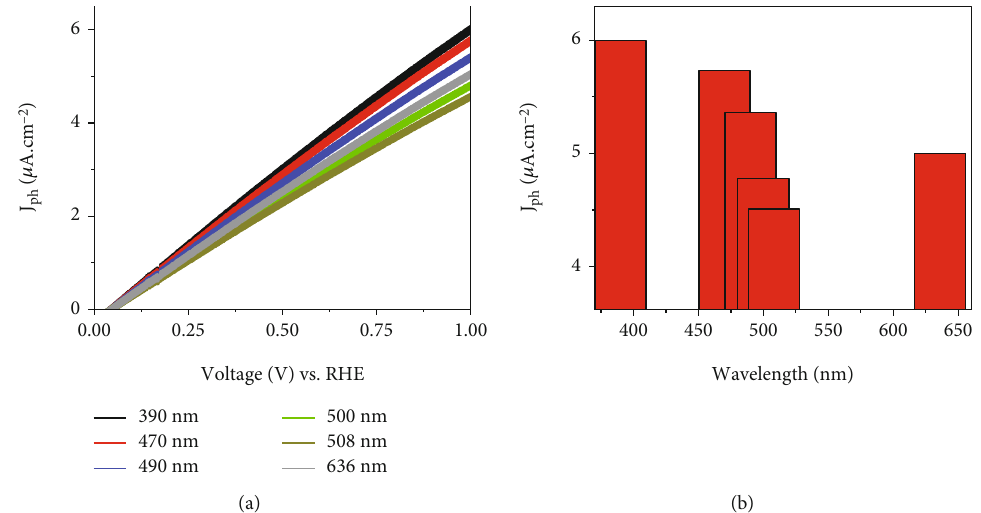
Figure 7: (a) The e ff ect of wavelengths (390 to 636nm) on current density for the electrode PANI/Ag density at +1V under di ff erent